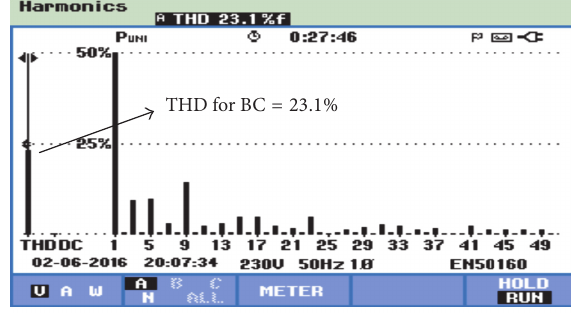
Figure 12: Output voltage THD for 60-degree bus-clamping tech- nique.